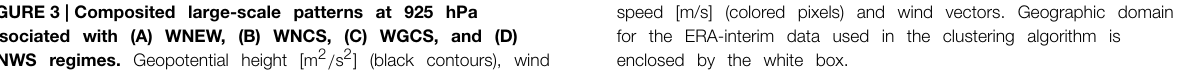
speed [m/s] (colored pixels) and wind vectors. Geographic domain for the ERA-interim data used in the clustering algorithm is enclosed by the white